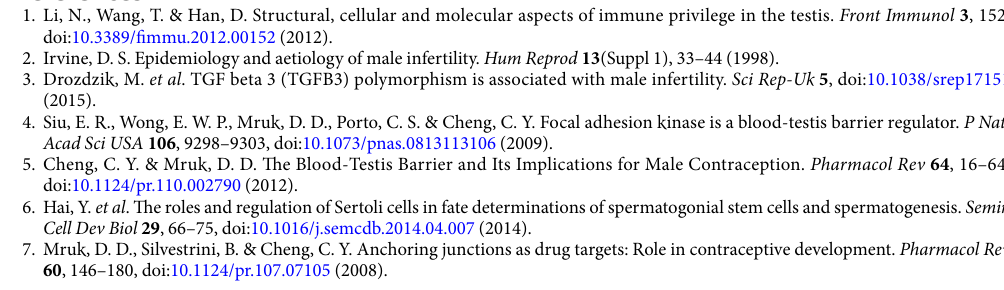
10 ScIeNtIfIc RePoRTS | 7: 6977 | DOI:10.1038/s41598-017-07229-1